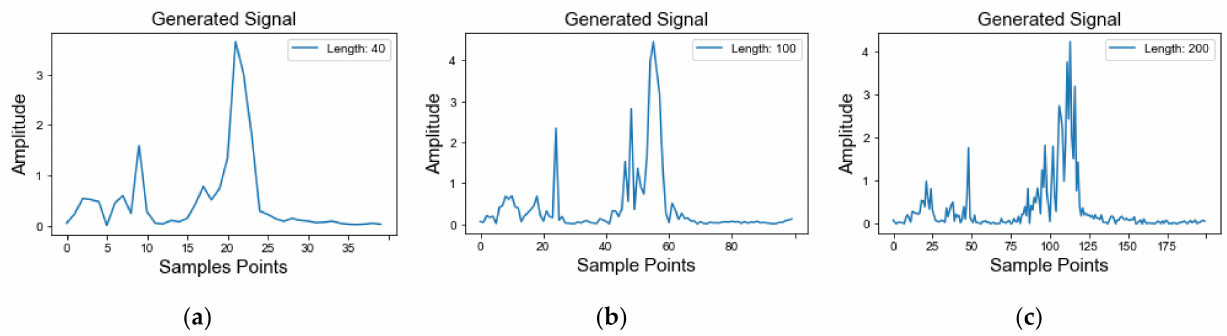
Figure 9. The spectrum of the multi-scale generated signal: ( a ) low-scale; ( b ) mesoscale; ( c )